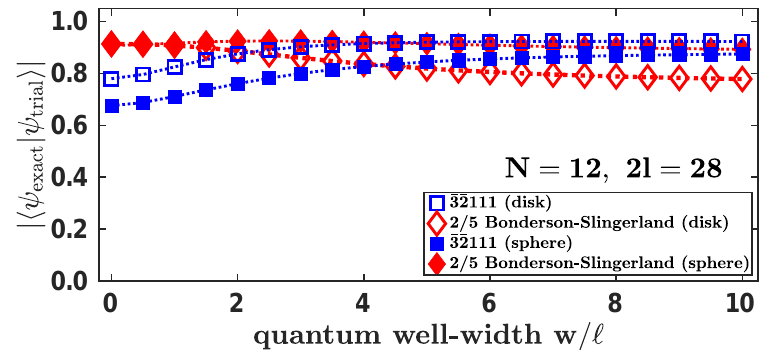
Figure 6: (color online) The overlap of the ¯3¯21 3 state (blue squares) with the ex- act second Landau level Coulomb ground state evaluated in the spherical geometry using the disk (open symbols) and spherical (filled symbols) pseudopotentials for various widths w for N = 12 electrons at 2 l = 28. This system aliases with the 2 / 5 Bonderson-Slingerland state; therefore, for comparison, we have also shown its overlaps (red diamonds) with the exact second Landau level Coulomb ground